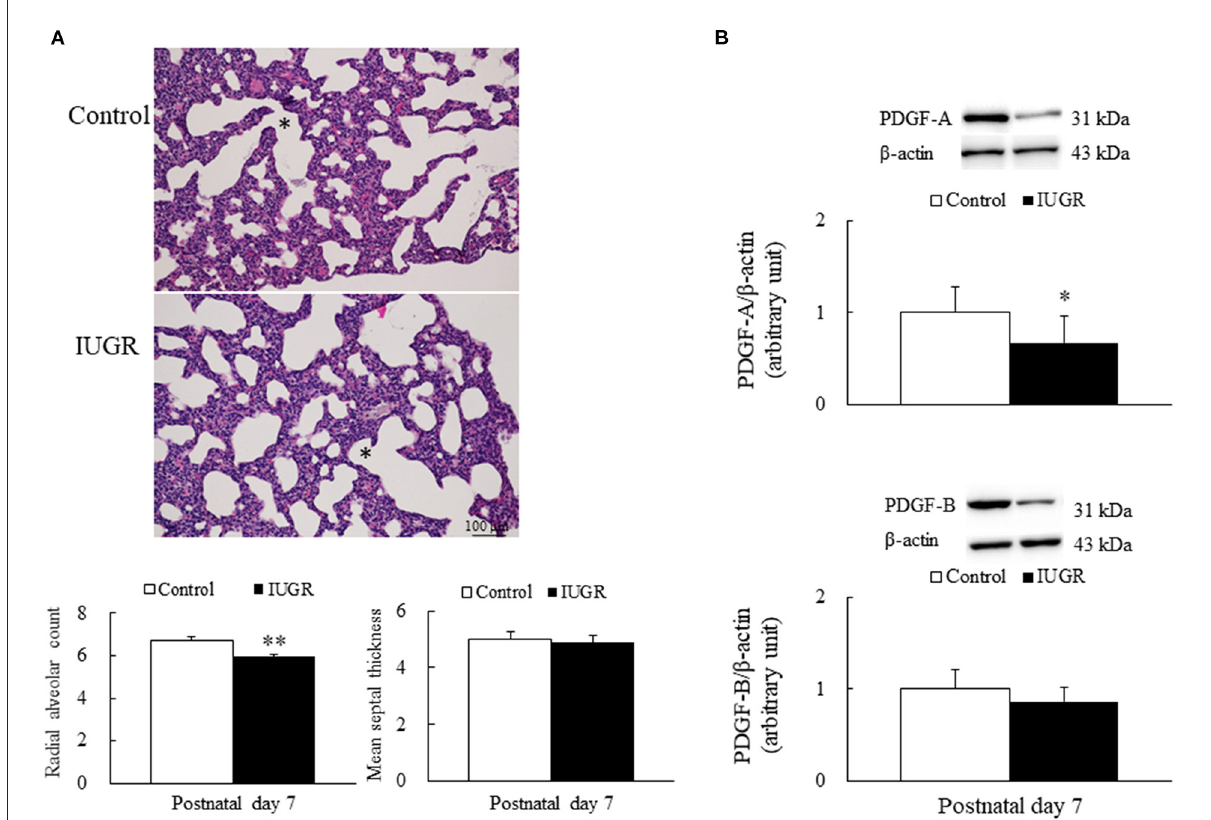
FIGURE2 (A) Representative lung sections stained with hematoxylin and eosin and radial alveolar count and mean septal thickness (B) representative Western blots of PDGF-A and PDGF-B in the lung tissue samples of the control and intrauterine growth restriction (IUGR) groups on postnatal day 7. * Denotes a respiratory bronchiole. Compared with the control rats, the IUGR rats had a significantly higher radial alveolar count, significantly lower average PDGF-A levels, and comparable mean septal thickness and PDGF-B levels. Data are presented as means ± SDs. * p < 0.05, ** p <